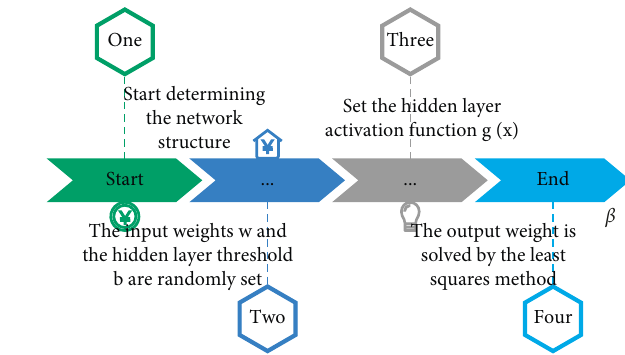
Figure 3: ELM algorithm flow